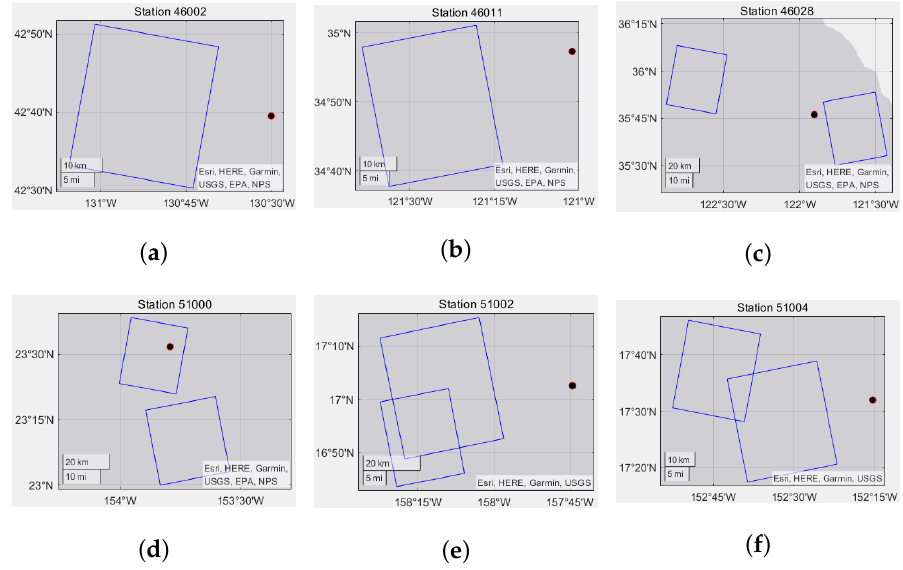
Figure 2. The map of matched GF3-02 SAR ocean scene (blue box) in NDBC’s ( a ) Station 46002, ( b ) Station 46011, ( c ) Station 46026, ( d ) Station 51000, ( e ) Station 51002, ( f ) Station 51004. The black dots represent the locations of NDBC